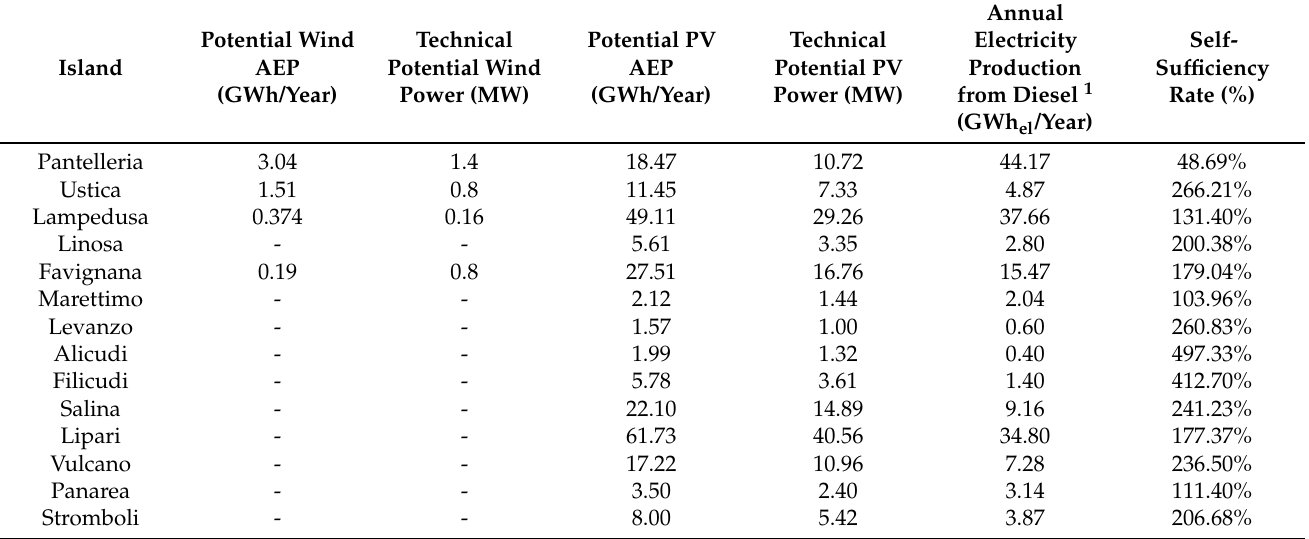
Table 15. Summary results and self-sufficiency